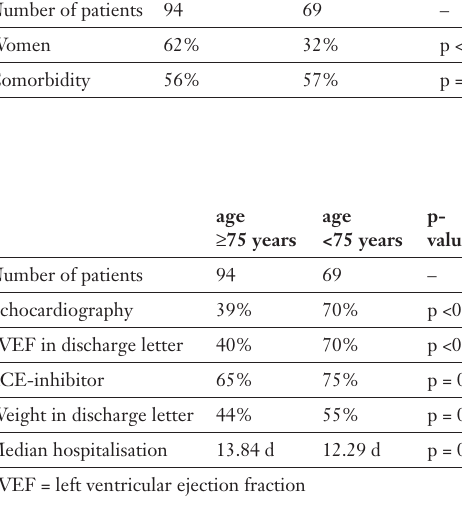
Patient characteris- tics in the CHF group.